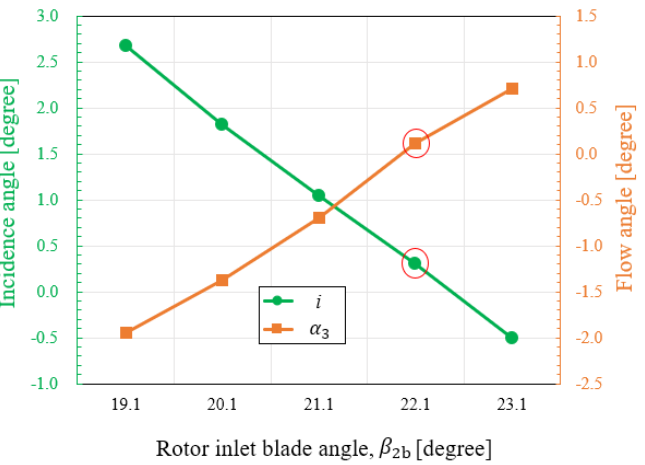
Figure 12. Incidence angle ( i ) and flow angle ( α 3 ) according to the first-stage rotor optimization of the radial outflow turbine.